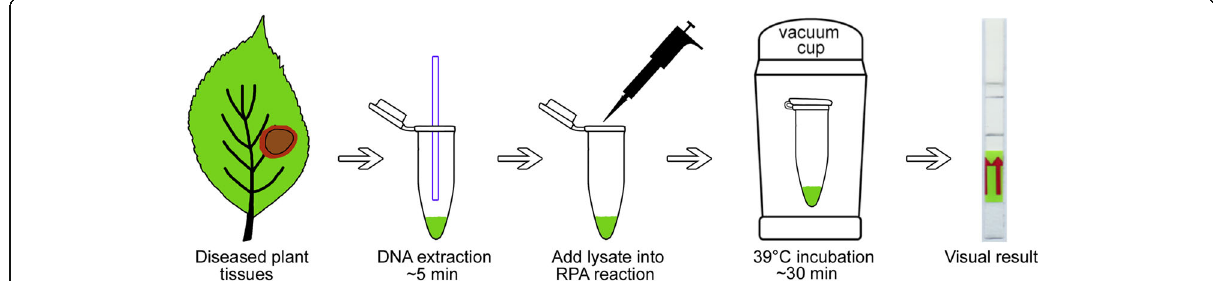
Fig. 3 Workflow of the entire equipment-free detection process, including simplified DNA extraction and the LF-RPA